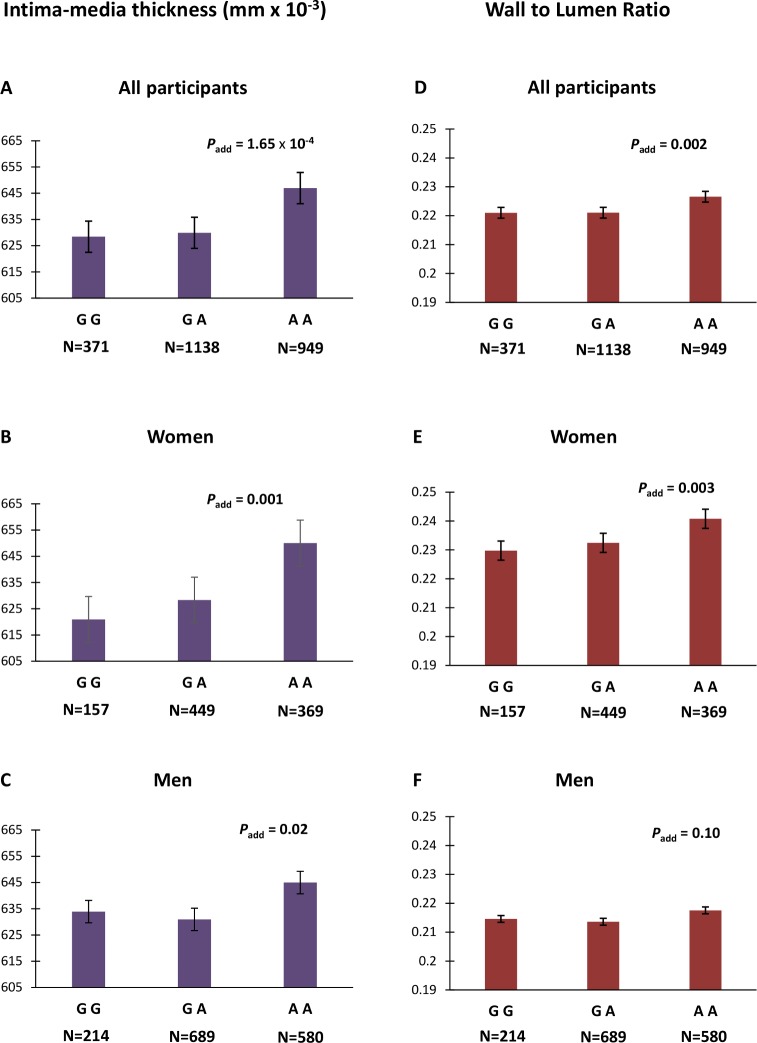
Association between rs9349379 and artery thickness in healthy controls.Intima-media thickness and wall to lumen ratio are presented by genotype in all (A,D) women (B,E) and men (C,F) participants. We indicated p-values for the linear regression analyses under the additive model adjusted for age, sex and body surface area.